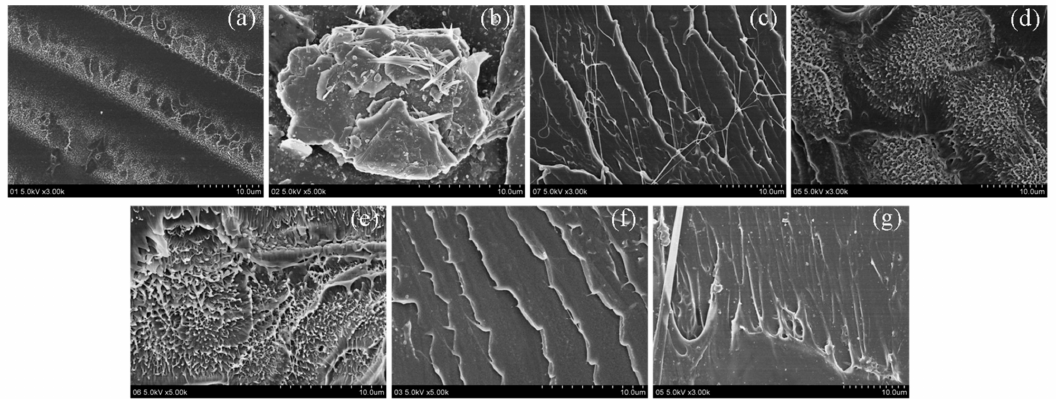
Figure 9. Scanning Electron Microscope (SEM) images of the fractured surfaces after tensile